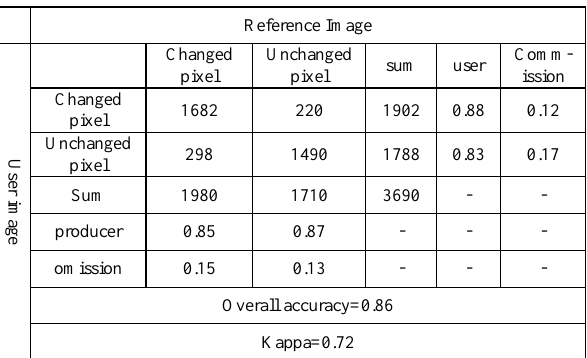
Table 9. Error matrix of Change detection result of pixel-based method combined dNDVI with CV